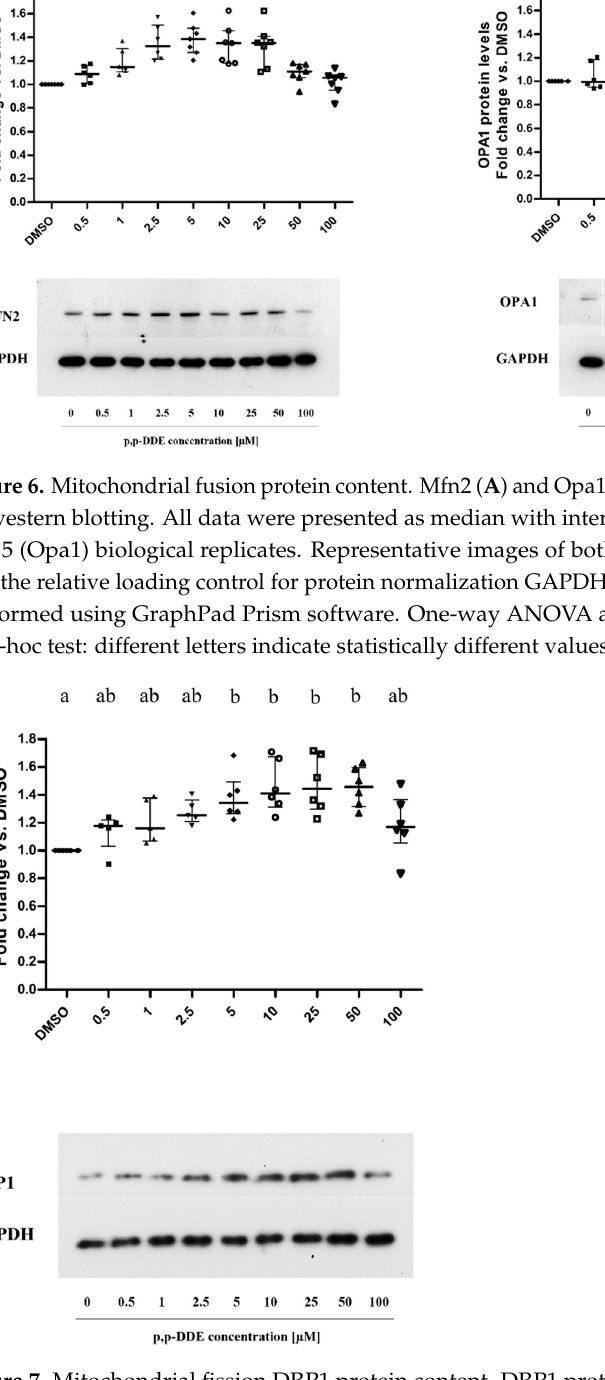
Figure 7. Mitochondrial fission DRP1 protein content. DRP1 protein levels were analyzed by western blotting. All data were presented as mean ± SEM for 5 or 6 biological replicates. The figure showed a representative image of DRP1 ( above ) and the relative loading control for protein normalization GAPDH ( below ). Statistical analyses were performed by GraphPad Prism software. One-way ANOVA analysis followed by Bonferroni’s post-hoc test: different letters indicate statistically different values.